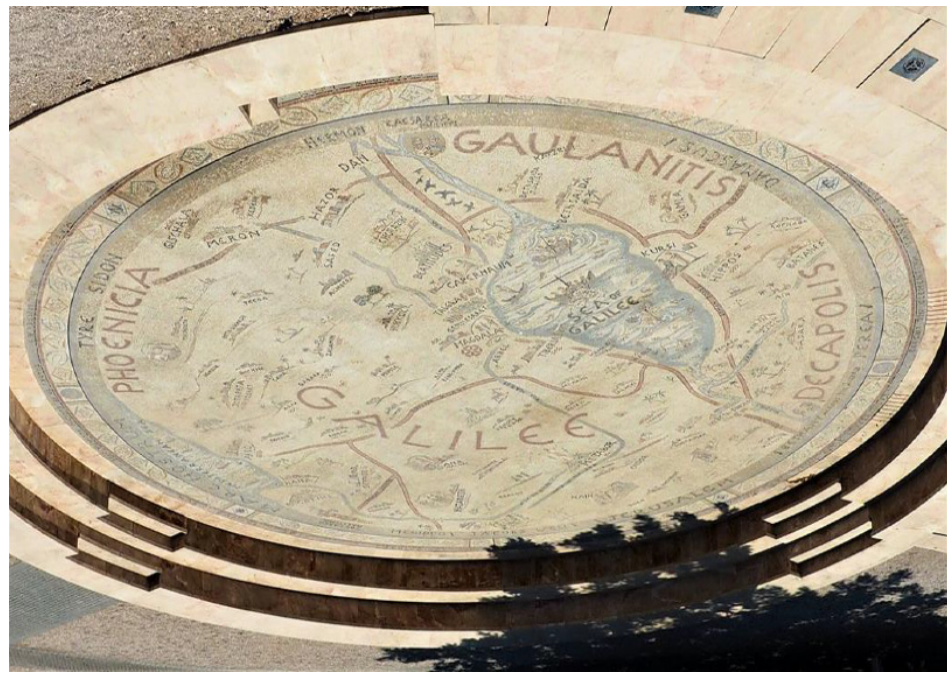
Figure 17. Map of the Galilee as a micro-Holy Land (photo: Assaf Pinkus).